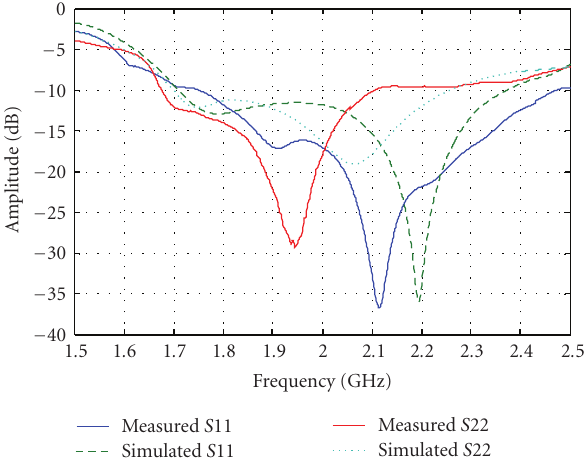
Figure 2: Simulated and measured return losses of the antenna (Design 1).